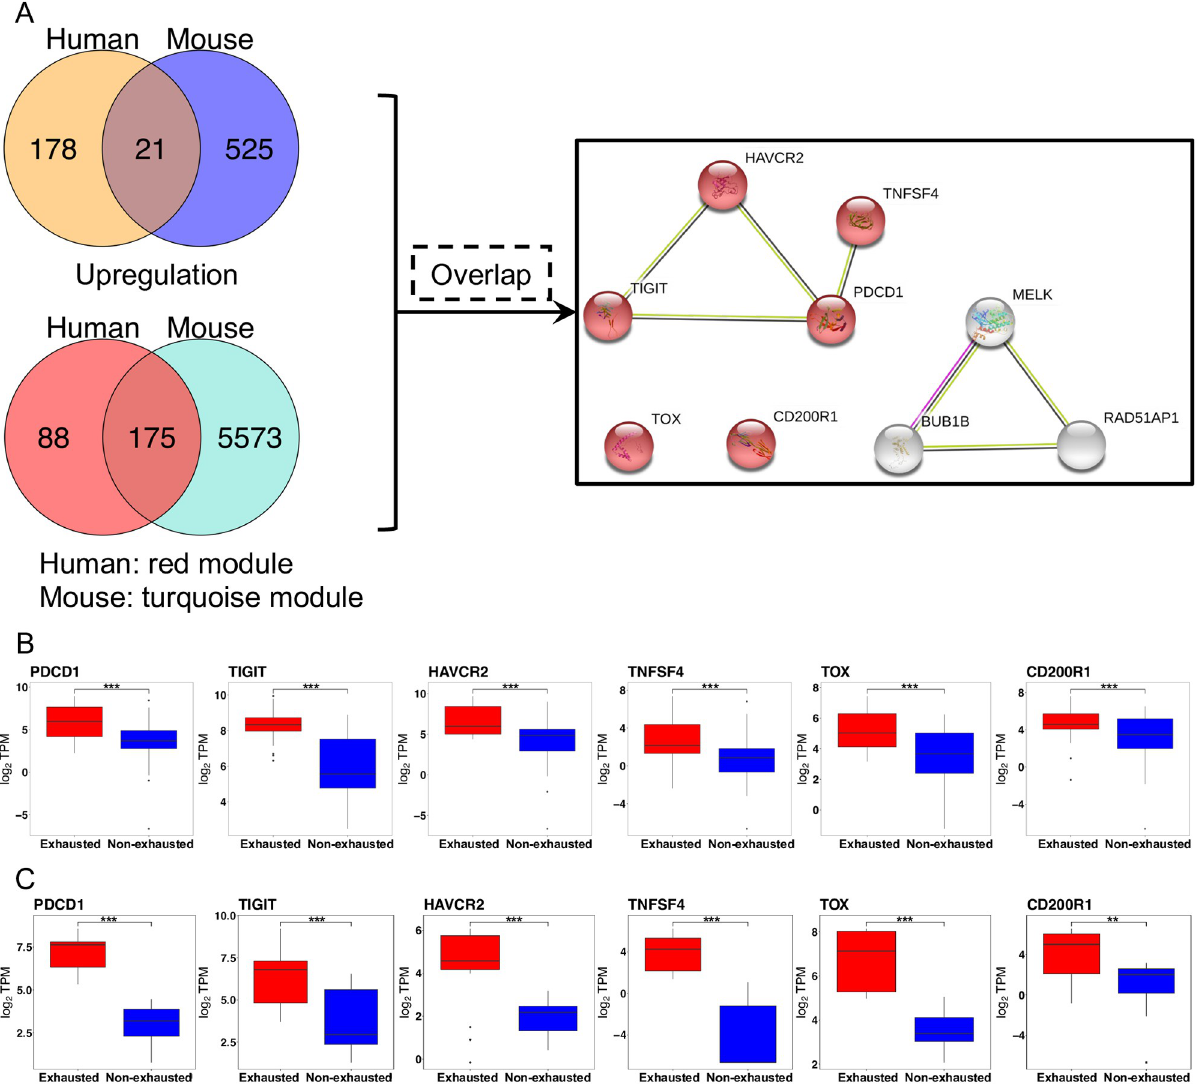
Fig 5. Overlap genes between human and mouse sets. (A) Overlap of upregulated genes in exhausted T-cells and most correlative modules with exhaustion between human and mouse, as well as protein associated network of nine proteins in both the overlap of upregulated genes and selected modules. Red colored nodes: regulation of immune system process (GO:0002682). (B) and (C) show the expression of selected genes at the mRNA level in human and mouse datasets from exhausted (red) and non-exhausted (blue) T cells, respectively. Median values are indicated by lines in the box and whisker plot. Hinge values and whisker 1.5 � interquartile range (IQR) values have been calculated using Tukey. Statistical analysis has been performed using an unpaired two-tailed Student’s t -test ( � P < 0.05, �� P < 0.01, ��� P < 0.001).